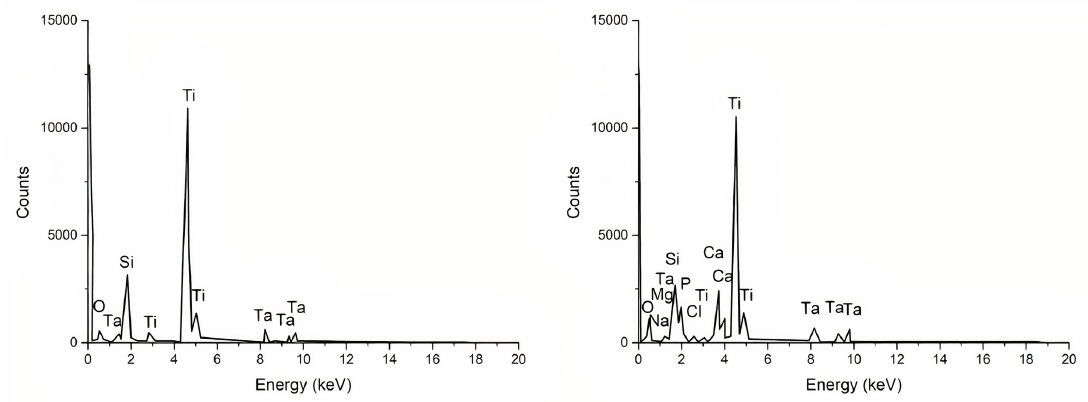
nanotube) leftwards and Group 2 (TiO 2